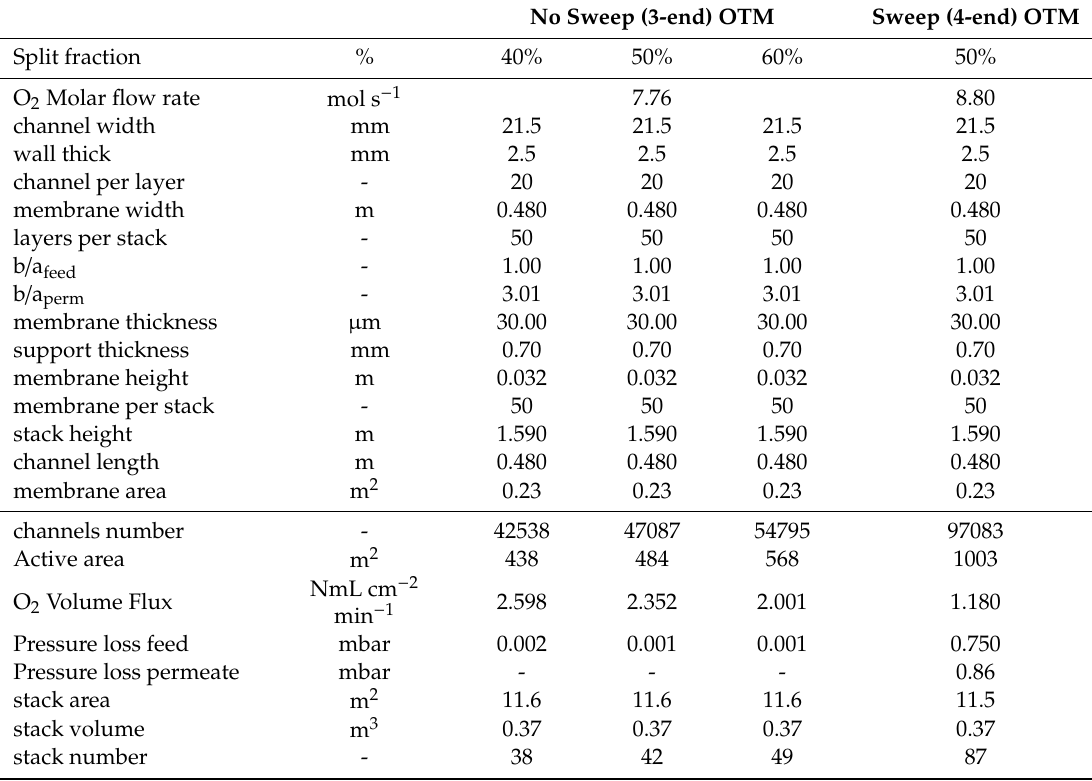
Table 3. Design characteristic summary for the membrane modules in Case C and Case